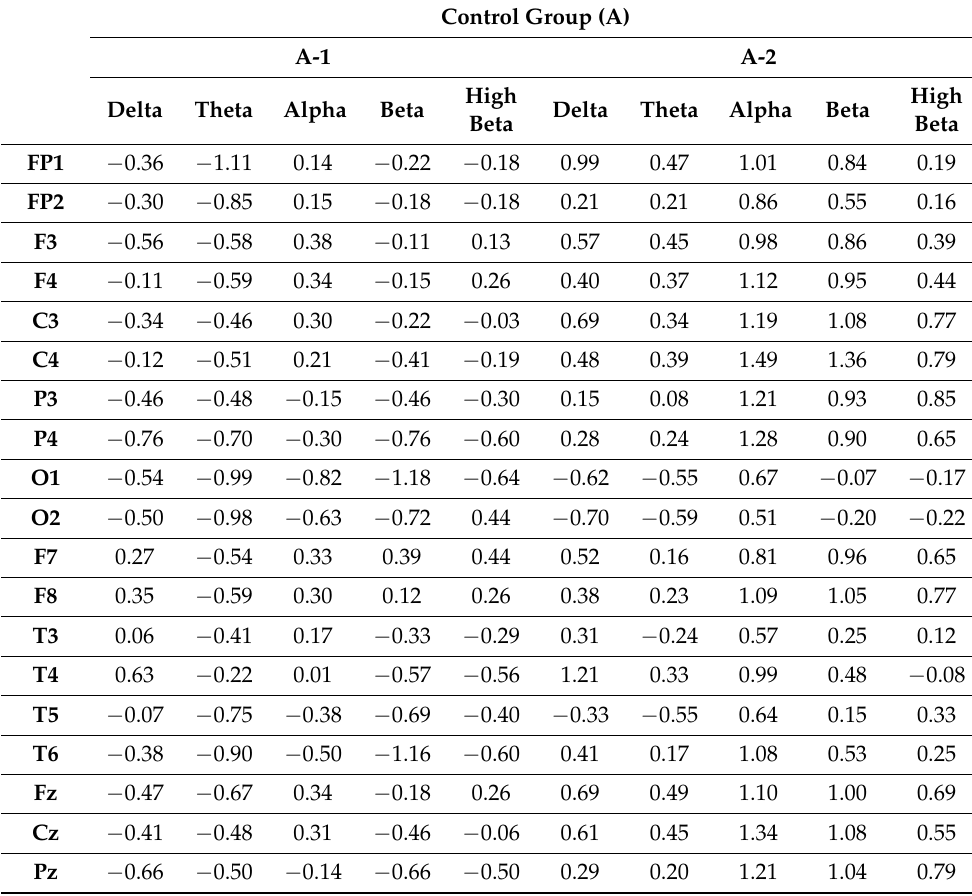
Table 3. EC FFT absolute power Z-score of the control group